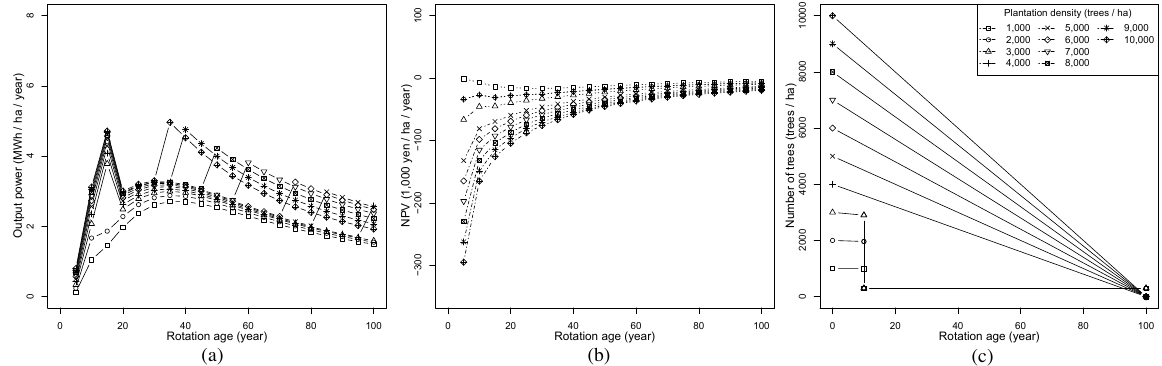
Figure 2. The electric output power ( a ) and NPV ( b ), when NPV was maximized for wood chip production, and the optimal thinning regime for the rotation age of 100 years ( c ). The legend of the plantation density is shown in the figure ( a ).